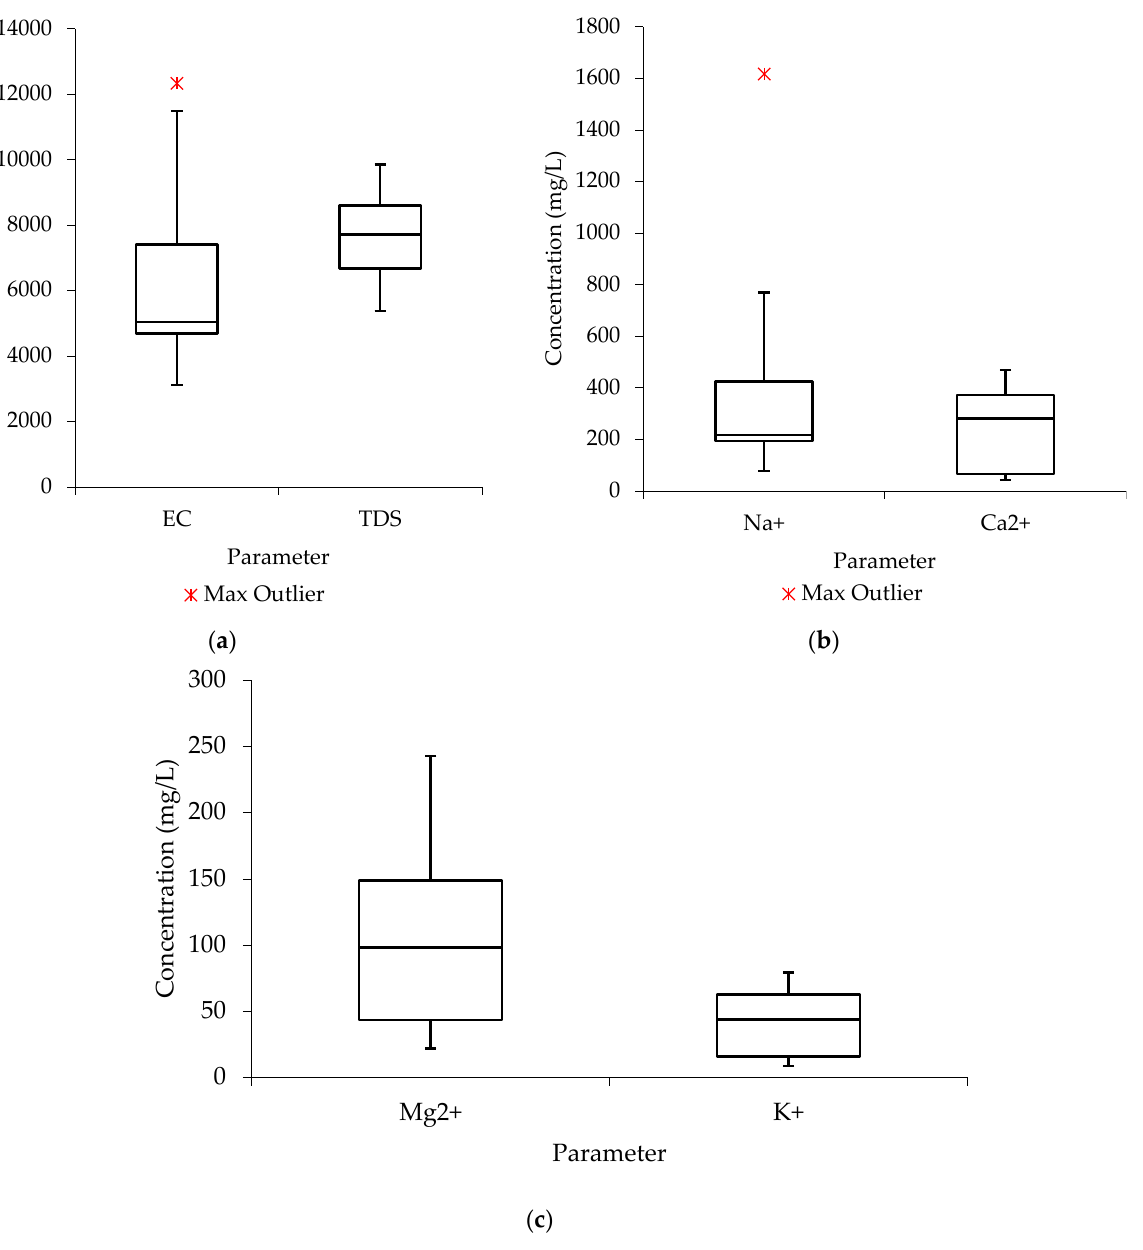
Figure 1. Data distribution before treatment (V f : 0.0035 L/s; pH: 6.4–12.5; T: 22.6–24.4 °C; n = 8) ( a ) electrical conductivity and total dissolved solids ( b ) sodium and calcium ( c ) magnesium and potassium and